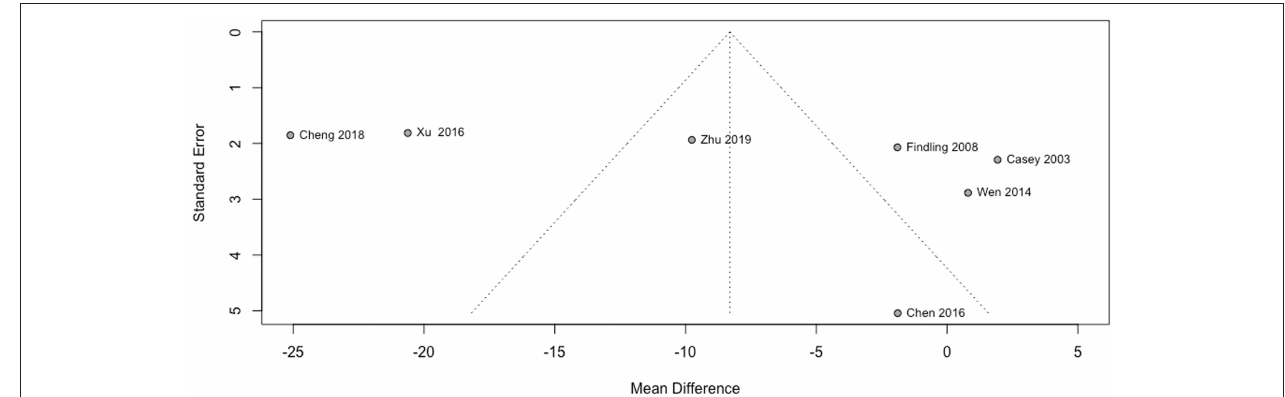
FIGURE 7 | Funnel